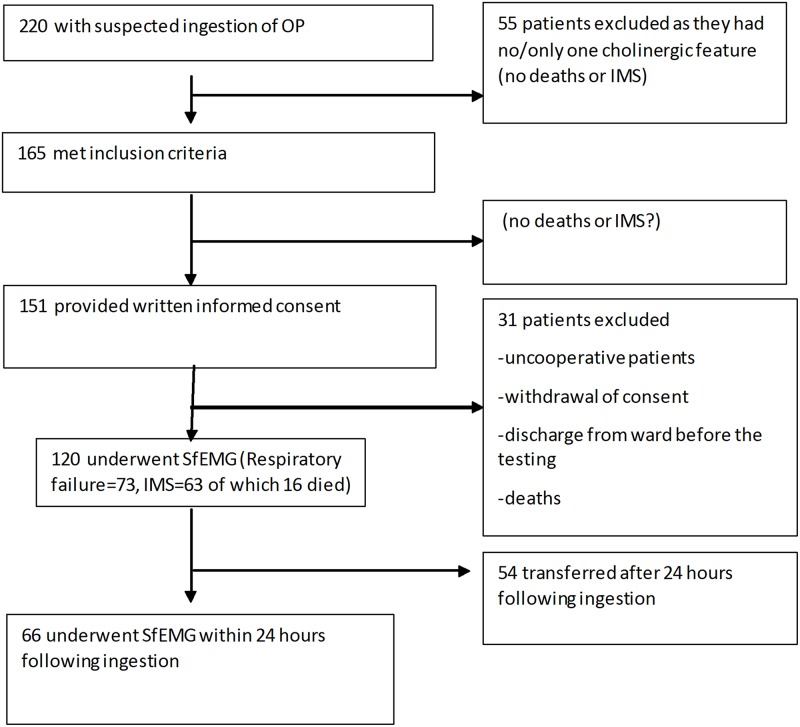
Patient recruitment flow chart.